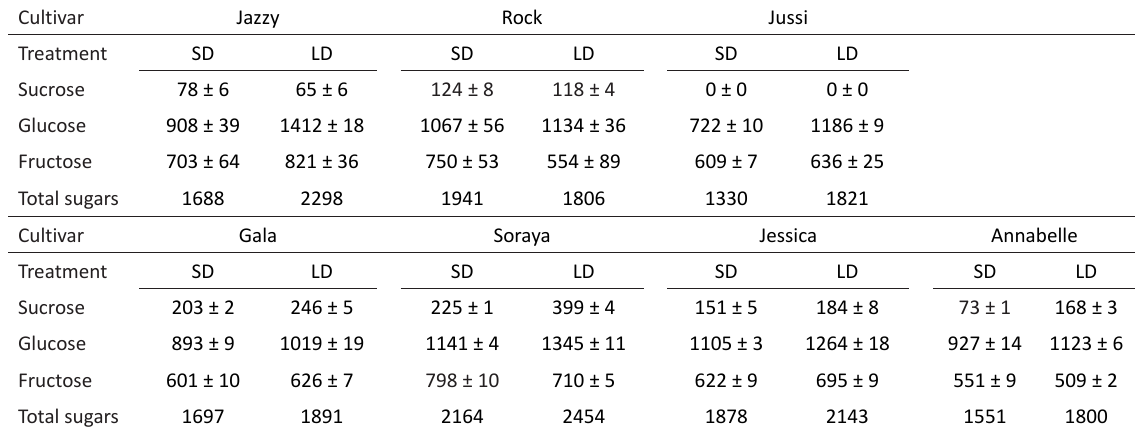
Table 2. Free sugar concentrations (mean ± standard deviation of three technical replicates) of potato tubers as mg 100 g -1 fresh weight as a result of short day (SD) and long day (LD)